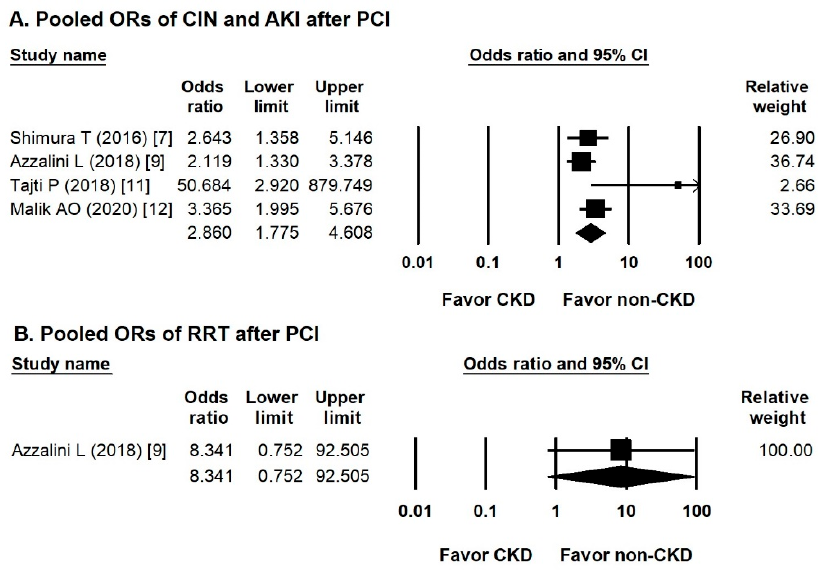
Figure 2. Forest plots of the renal events. ( A ) Forest plots of the incidence of contrast-induced nephropathy or acute kidney injury between the CKD and non-CKD groups from four studies. ( B ) Forest plots of the incidence of renal replacement therapy between the CKD and non-CKD groups from one study.